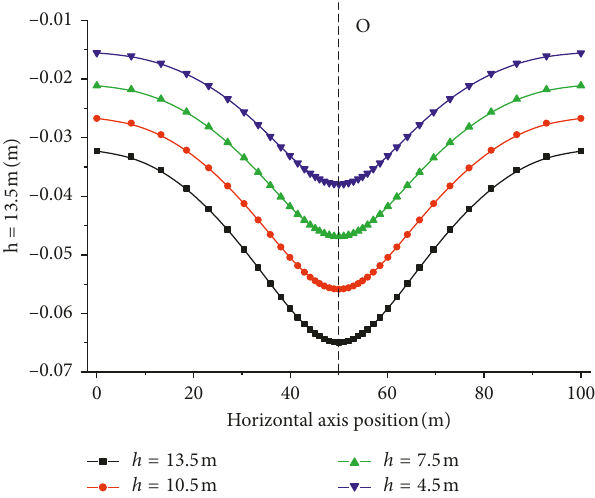
Figure 16: Comparison of final surface subsidence corresponding to different head